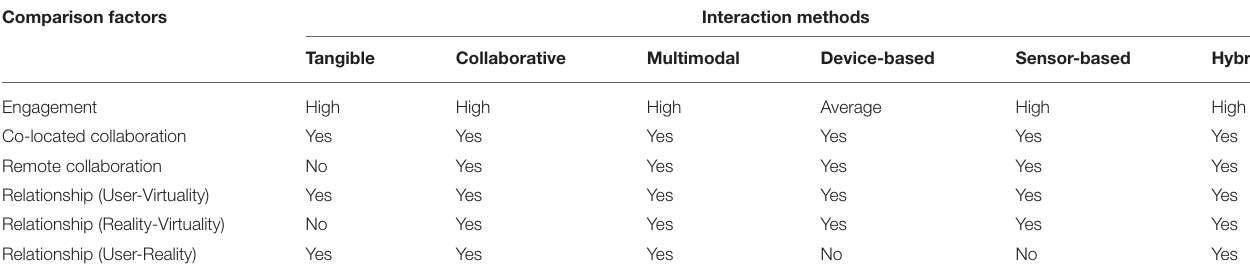
TABLE 2 | Comparison of interaction methods (summary of Table 4 ). Comparison